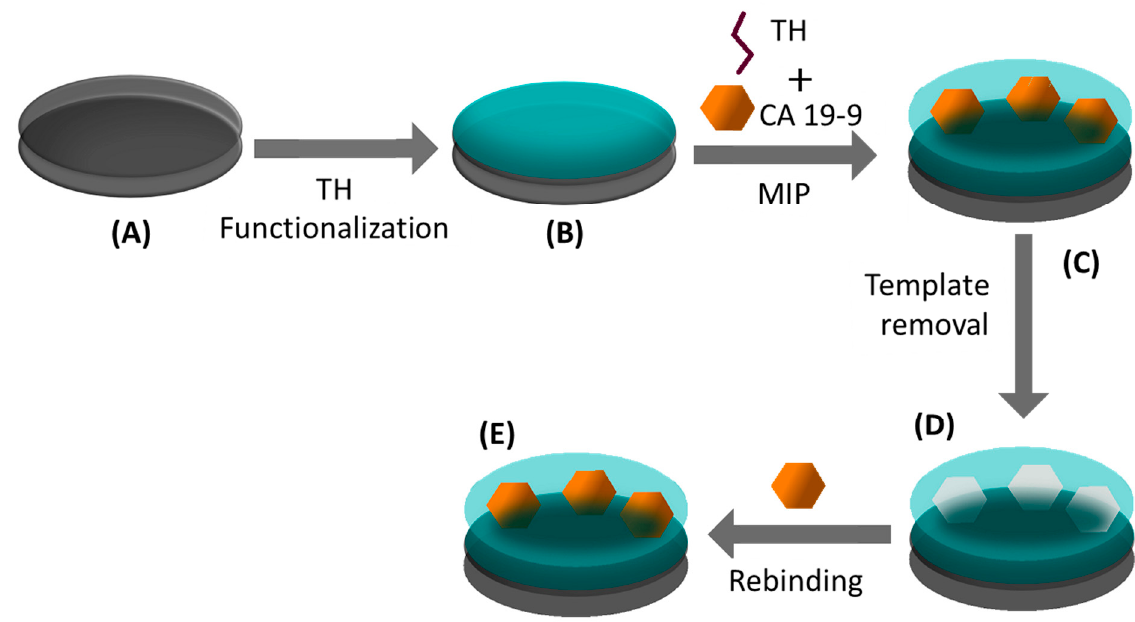
Figure 1. Schematic representation of the assembly of the biosensor. ( A ) Clean electrode; ( B ) modification of the electrode with thionine (TH); ( C ) electropolymerization of TH to generate the molecularly imprinted polymer (MIP) materials with the template CA 19-9; ( D ) template removal; and ( E ) CA 19-9 rebinding to the imprinted sites.